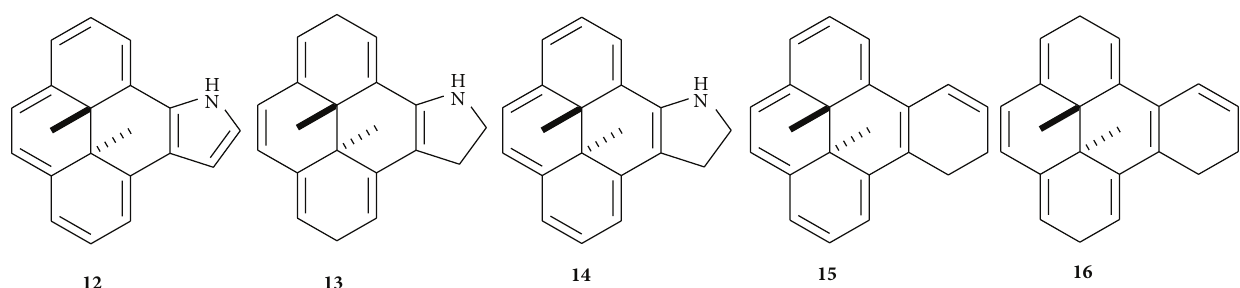
Figure 3: Nonaromatic and nonconjugated reference models required for quantification of aromaticity of pyrrole fused dihydropyrene 12 through (2) and